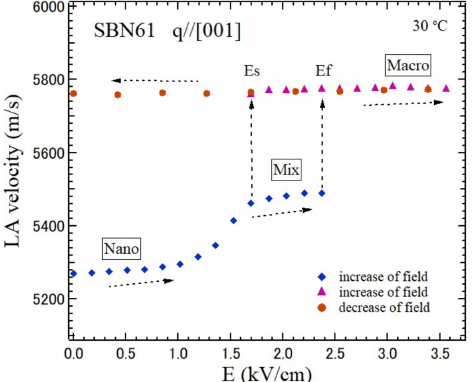
Figure 11. Variation of the LA velocity of SBN61 by the application of the electric field along the c -axis at 30 ◦ C. By the application of the electric field along the c -axis to a (Nano) nanodomain state, (Mix) mixed, and (Macro) macrodomain states appeared